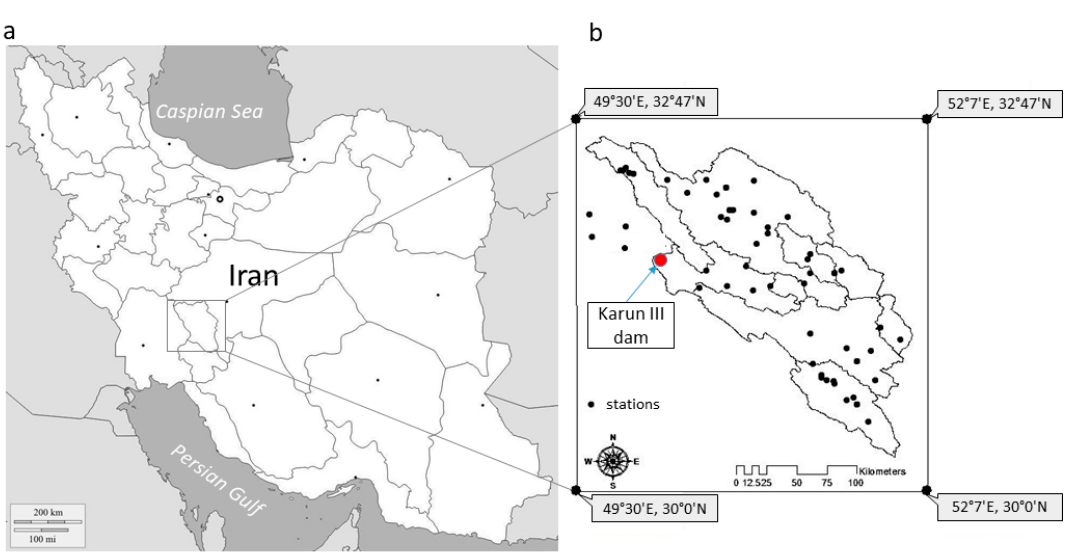
Figure 3. Location map of ( a ) Karun-III watershed in Iran [53], together with ( b ) the location of the dam and meteorological stations.